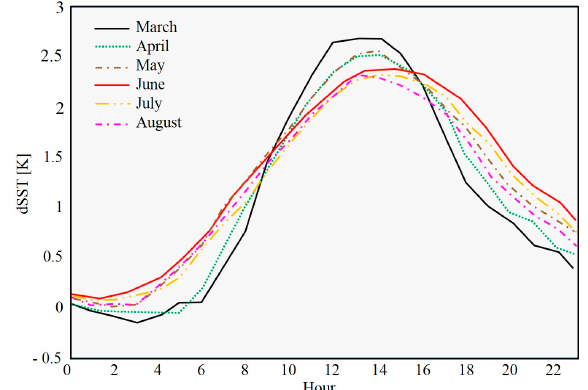
Figure 6. Monthly variation of the SST diurnal cycle from 00:00 to 23:00 for the spring and summer months. Only grid cells showing anomalies >2 K at least once a day are used. For those grid cells, all hourly values are used [44]. Reprinted from [44] with permission from Elsevier.